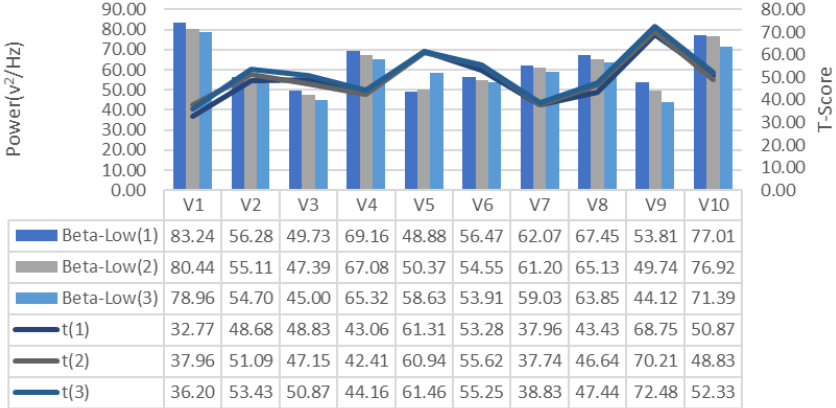
Figure 7. GDTS per round on track with Alpha band power game performance (T-Score) relationship.